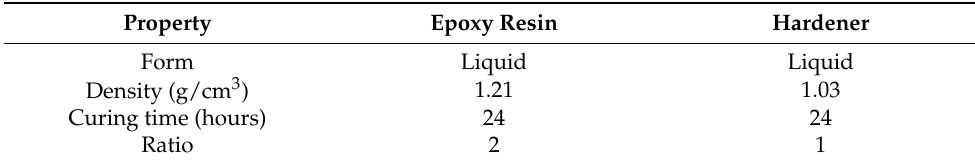
Table 1. Properties of epoxy resin and hardener.